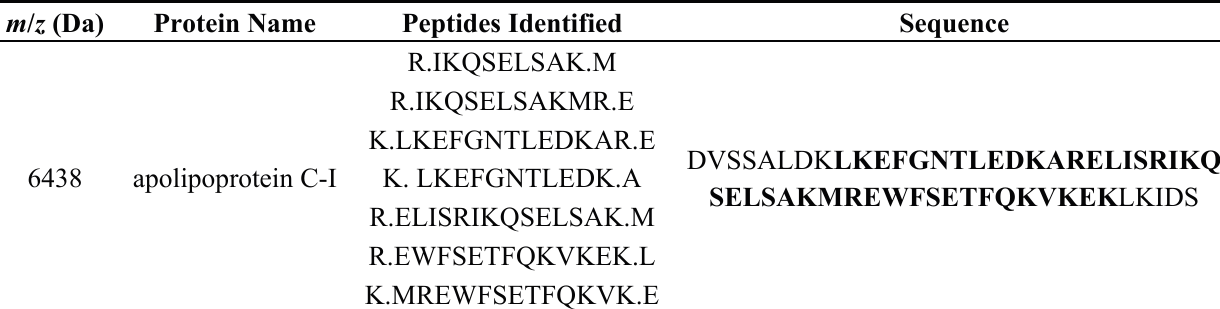
Table 2. Peptide sequences obtained after enzymatic digestion of the protein and peptide segments with m / z of 6438 Da. Peptide sequences identified by the Bioworks database are in